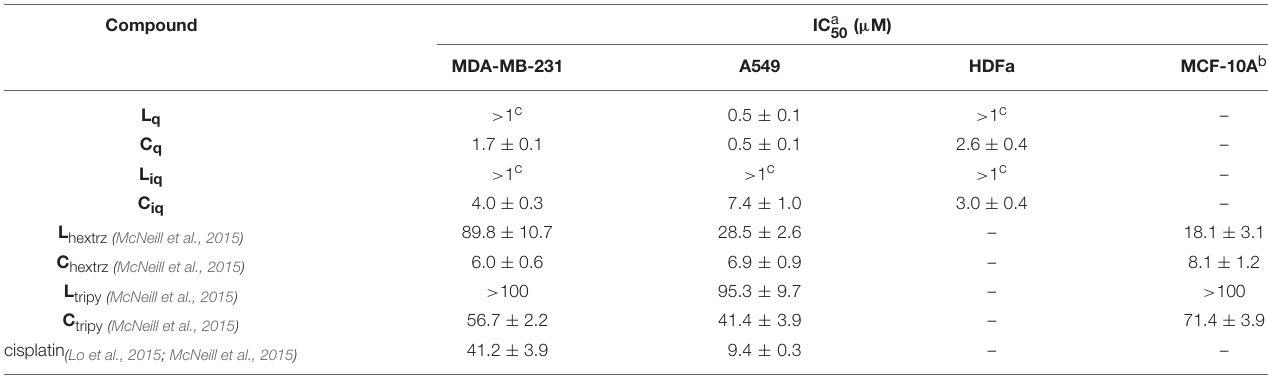
TABLE 1 | Half-maximal inhibitory concentrations (IC 50 ) of ligands L q and L iq , and cages C q and C iq architectures at